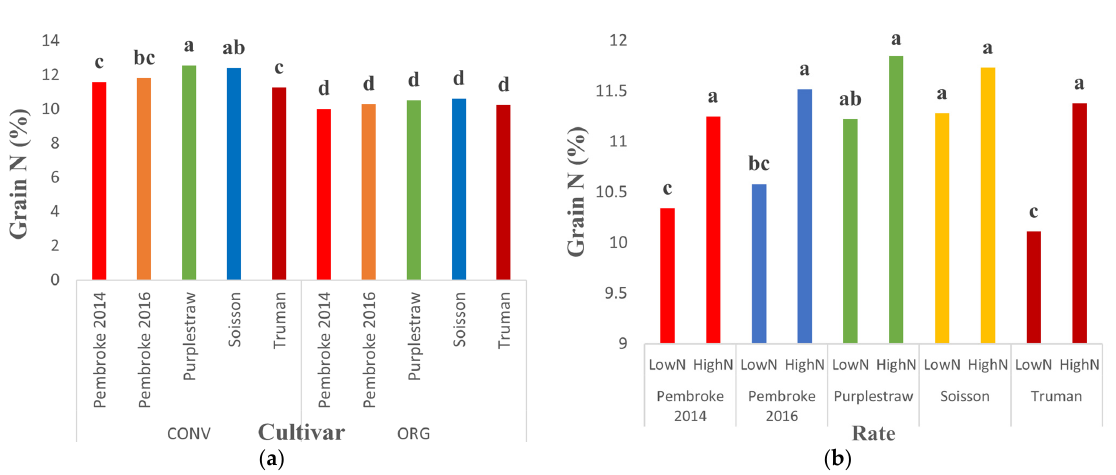
Figure 3. Grain N for study cultivars, as affected by system ( a ) and N rate ( b ) in Y1. Bars with the same letters within each figure are not significantly different based on Tukey’s honest significant difference (HSD) test performed at α = 0.05.